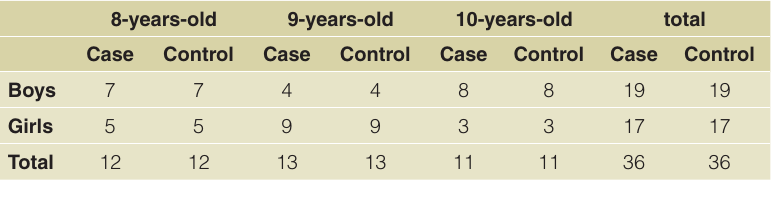
Table 3. Comparison of canine and first premolar eruption percentages and their difference between case and control groups.